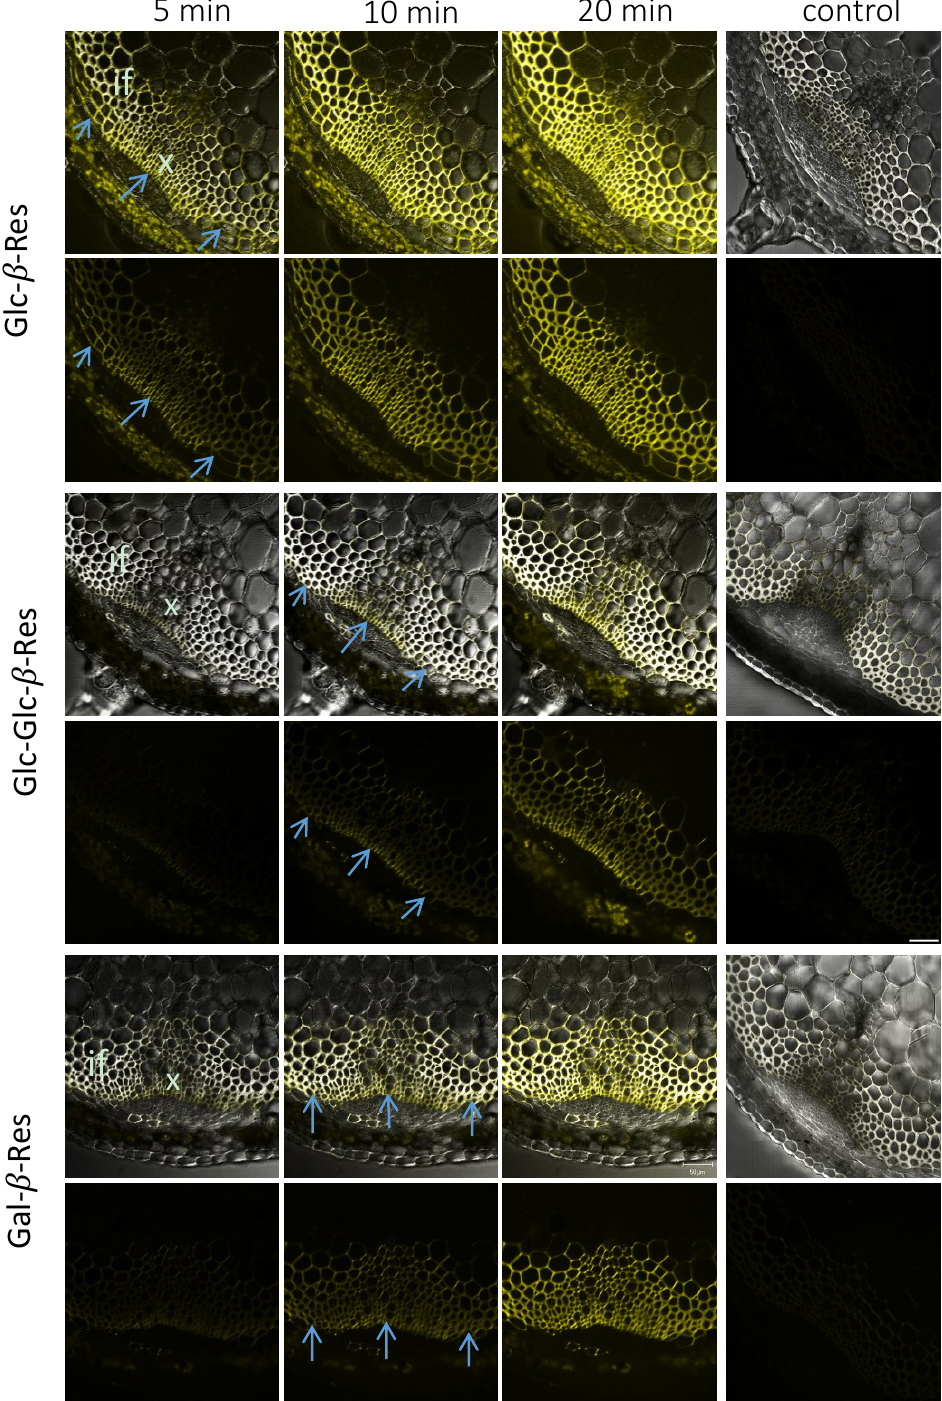
Figure 2. Distribution of signals in the inflorescence stem sections of Arabidopsis from Glc-β - Res, Glc-Glc - β - Res and Gal-β - Res substrates after incubations for the specified durations. The control sections were boiled for 30 min before incubation with the specified substrate for 20 min. Upper rows represent the transmitted light channel and the superimposed yellow fluorescence channel corresponding to resorufin signals, and the lower rows represent the yellow channel only. Blue arrows show differentiating sclerenchyma cells. if, interfascicular fibers; x, xylem. Bar = 50